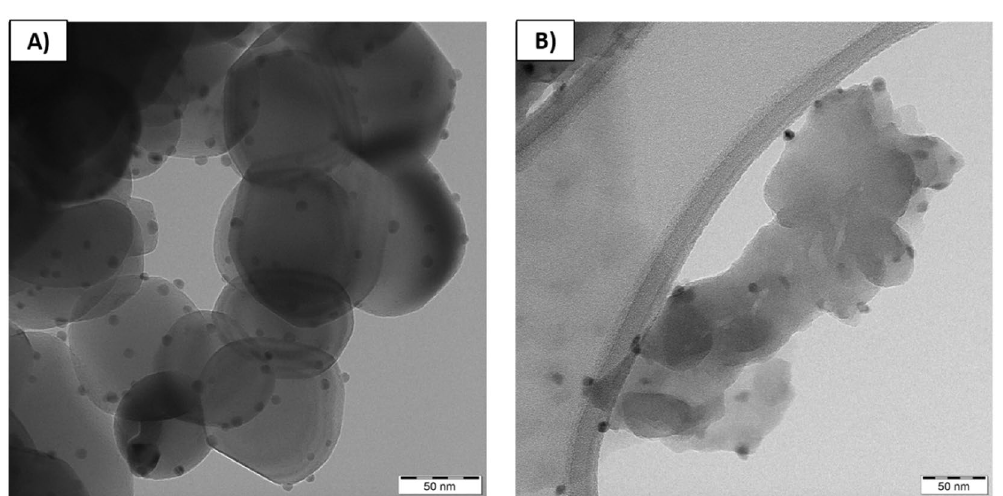
Figure 9. SEM images of: ( A ) TiO 2 -A, ( B ) TiO 2 -A-0.5% Ag, ( C ) TiO 2 -A-2.5% Ag at 50,000×magnification, and ( D ) MM-g-CN, ( E) MM-g-CN-0.5% Ag, ( F ) MM-g-CN-2.5% Ag at 40,000×magnification.